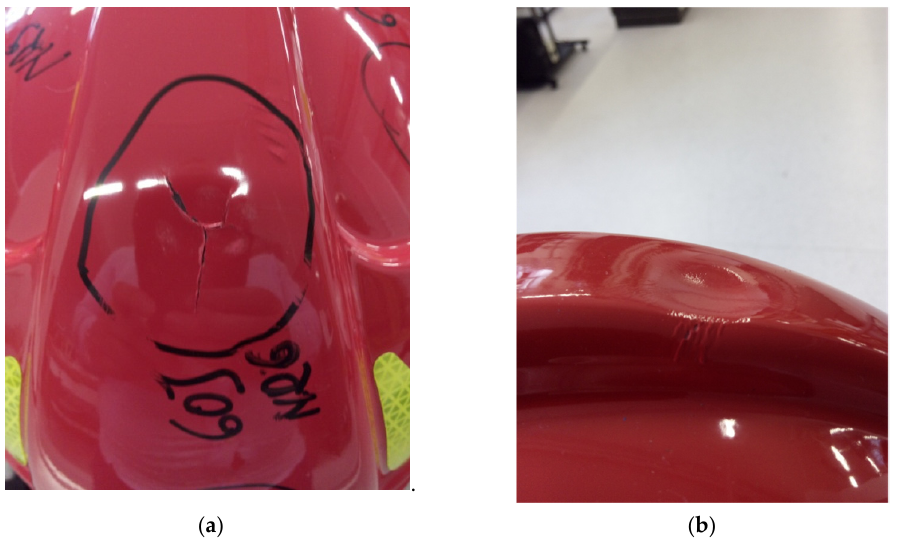
Figure 11. Crack and deformation of the CV102 helmet surface: ( a ) depending on thermal shock standard temperature value (20 °C), ( b ) extreme temperature value (thermal shock at the temperature of 140 °C for 10 min).